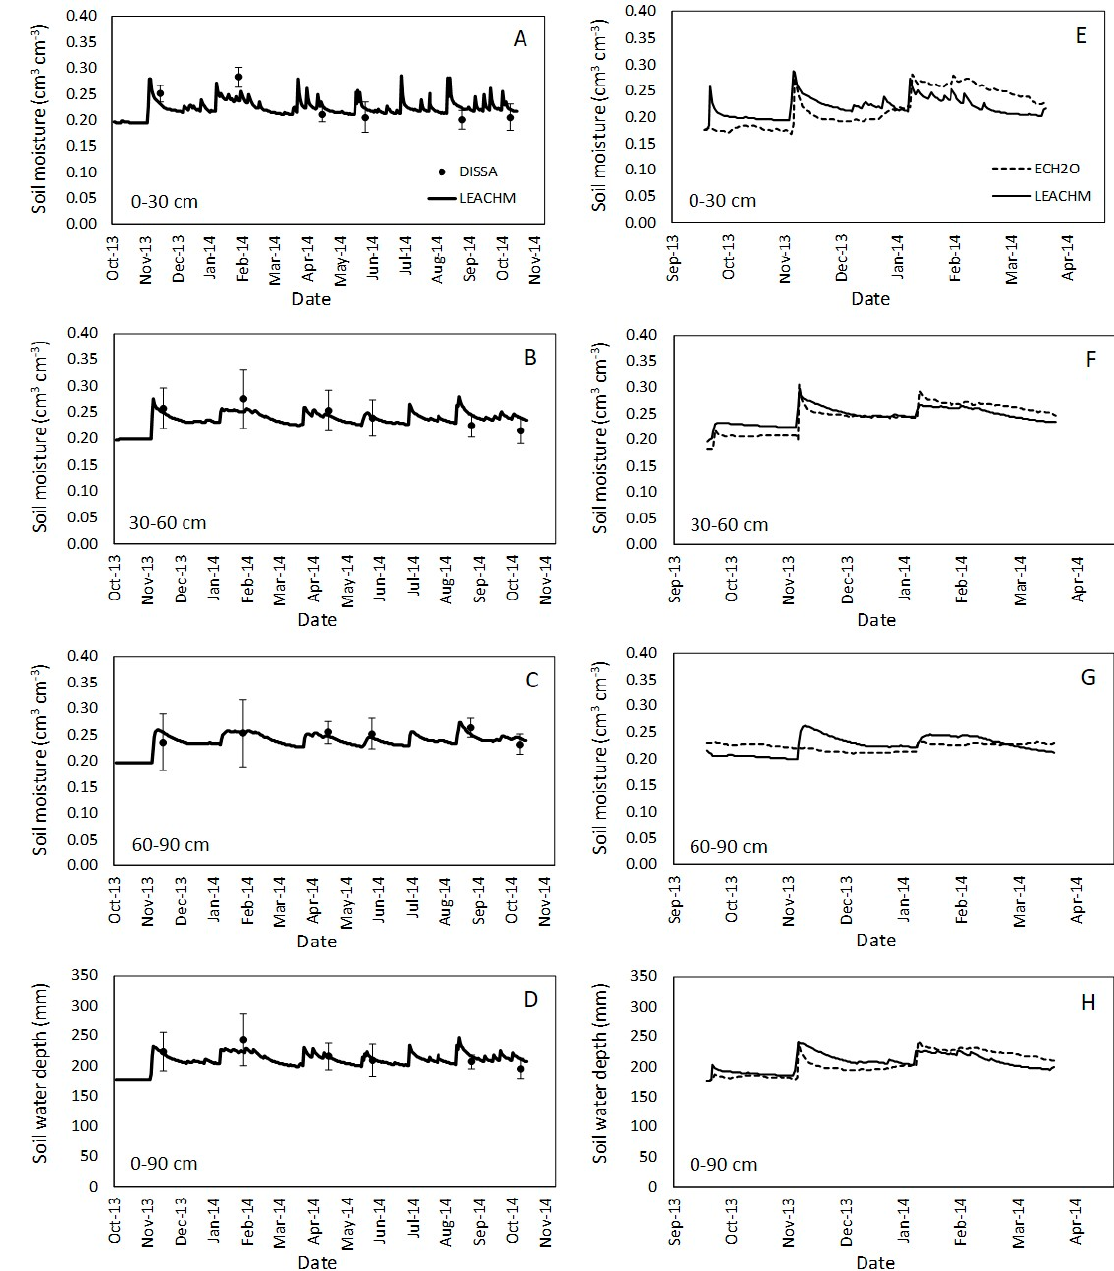
Figure 5. Soil moisture in the three soil layers ( A – C , E – G ) and soil water depth in the soil profile ( D , H ) measured from disturbed soil samples ( A – D , circles), with ECH2O sensor ( E – H , dashed line) and simulated with Leaching Estimation and Chemistry Model (LEACHM) (continuous line) for calibration period under fallow system. Vertical bars represent the standard deviation.